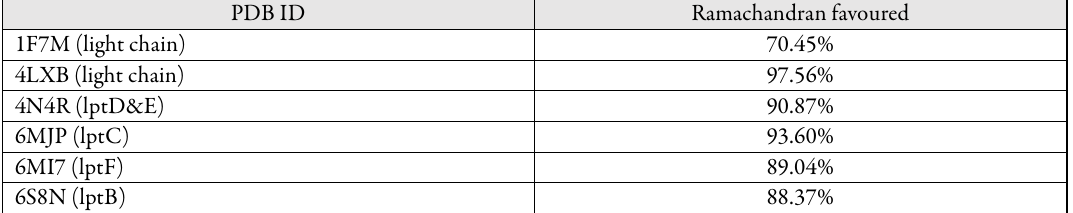
Table 2. Ramachandran favoured values of macromolecules respectively PDB